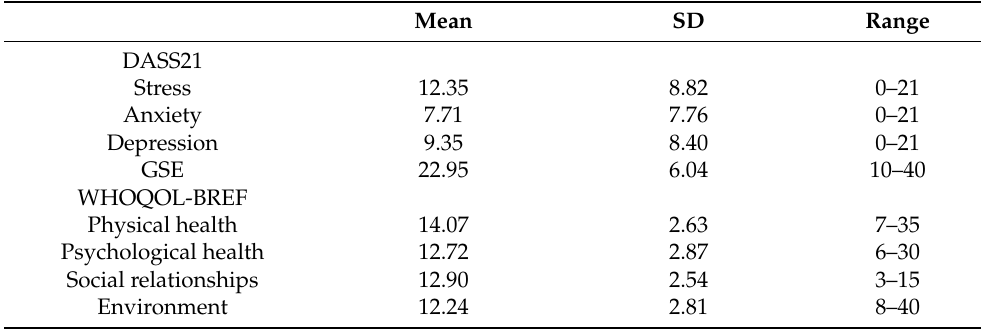
Table 1. The participants’ mean score and standard deviation for the scales of DASS21, GSE, and WHOQOL-BREF ( n =